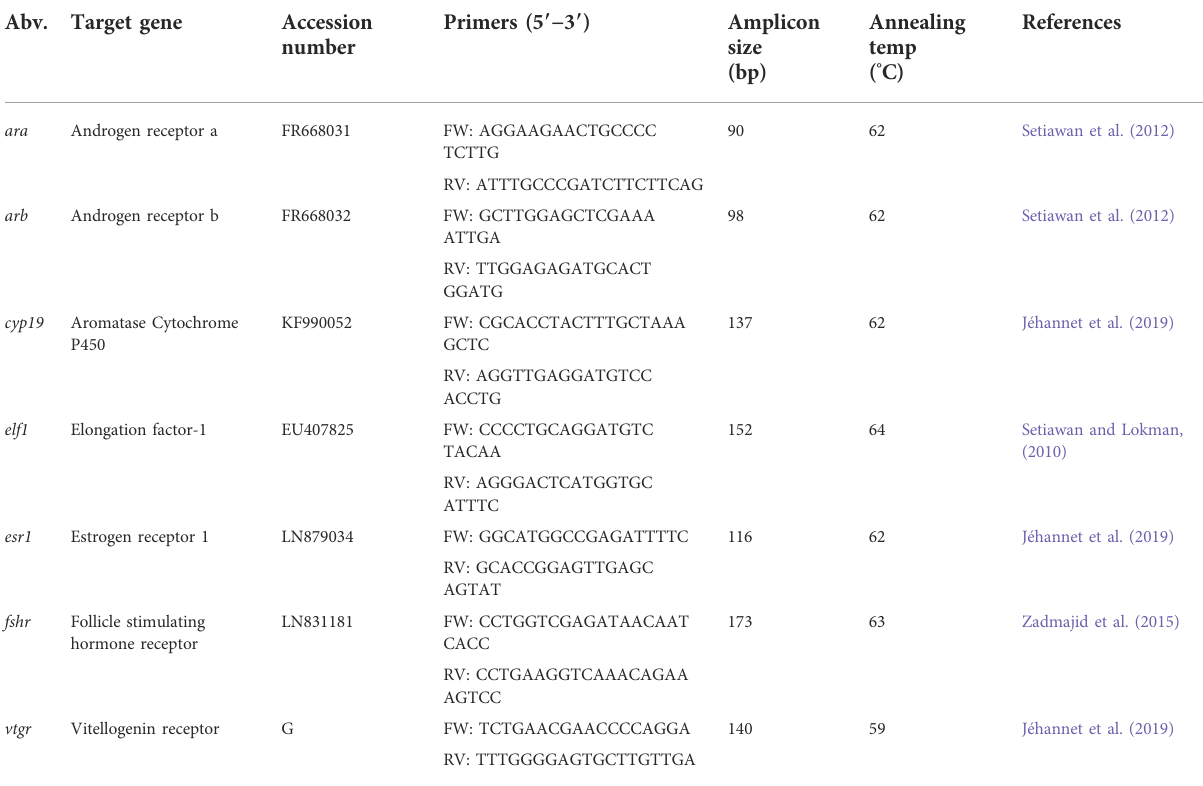
TABLE 1 Primers for each of the targeted genes, where Abv: gene abbreviation; Accession number: the Genbank accession number for A. anguilla ; G: sequence obtained from the A. anguilla genome by Jéhannet et al. (2019); Amplicon size: the PCR product size in base pairs (bp) of nucleotides; annealing temp ( ° C): annealing temperature of target gene; Reference: the literature source from which the original primers were obtained from. Abv. Target